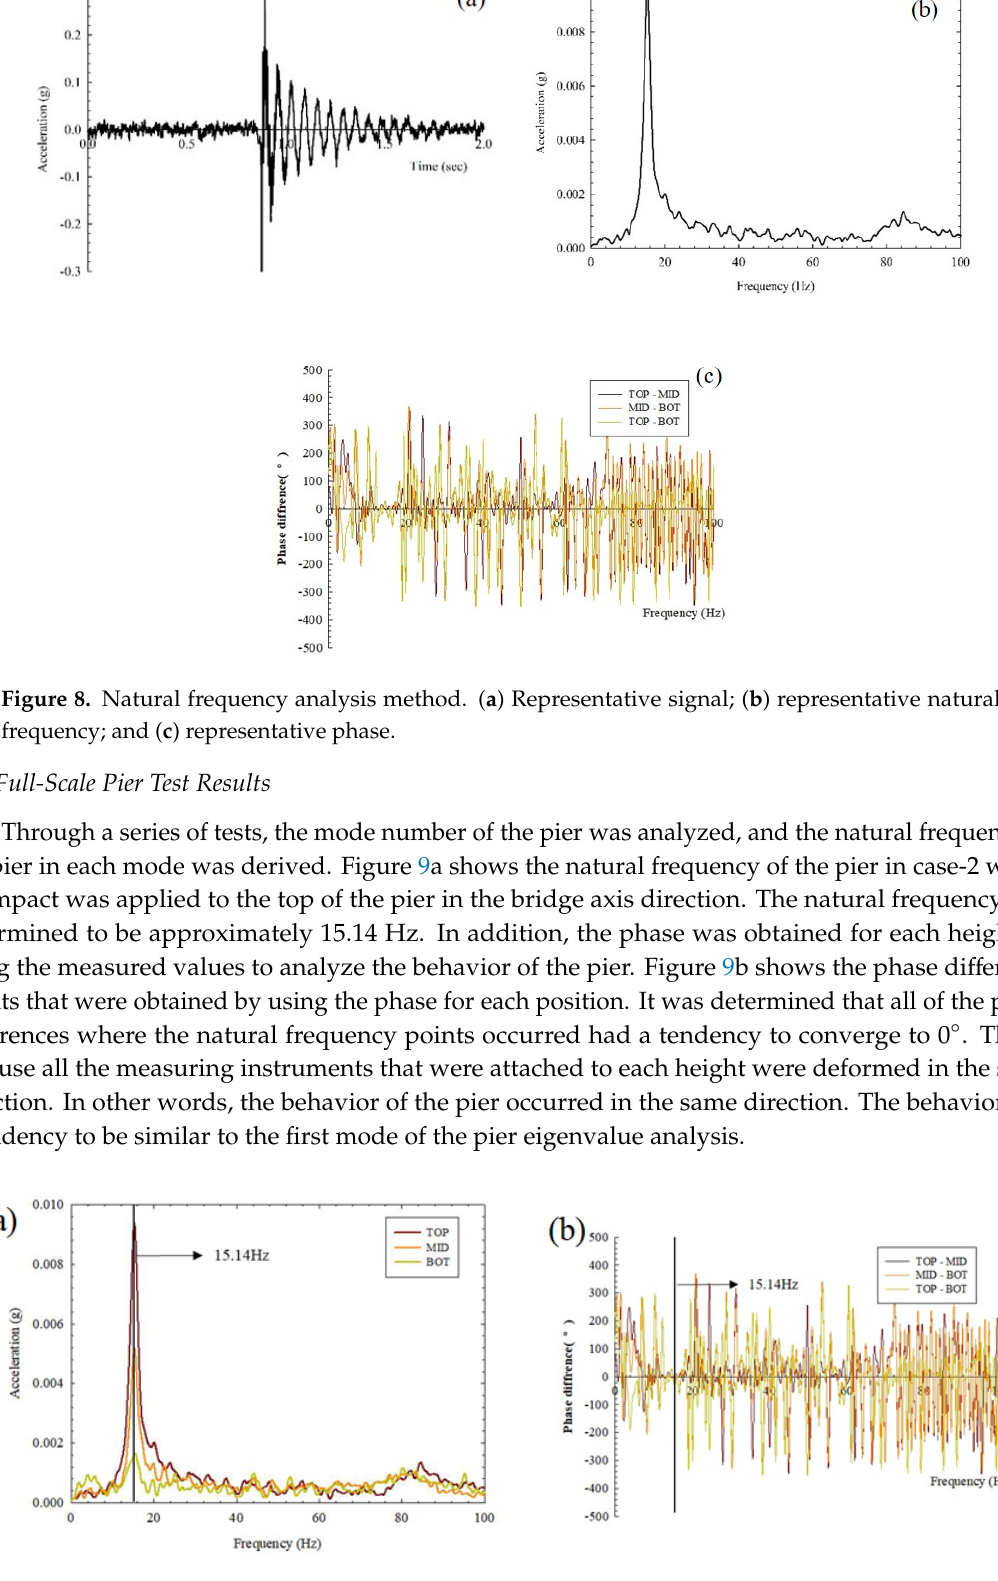
Figure 9. Results of the impact vibration load test in the bridge axis direction. ( a ) Natural frequency of the first mode and ( b ) phase difference of the first mode.